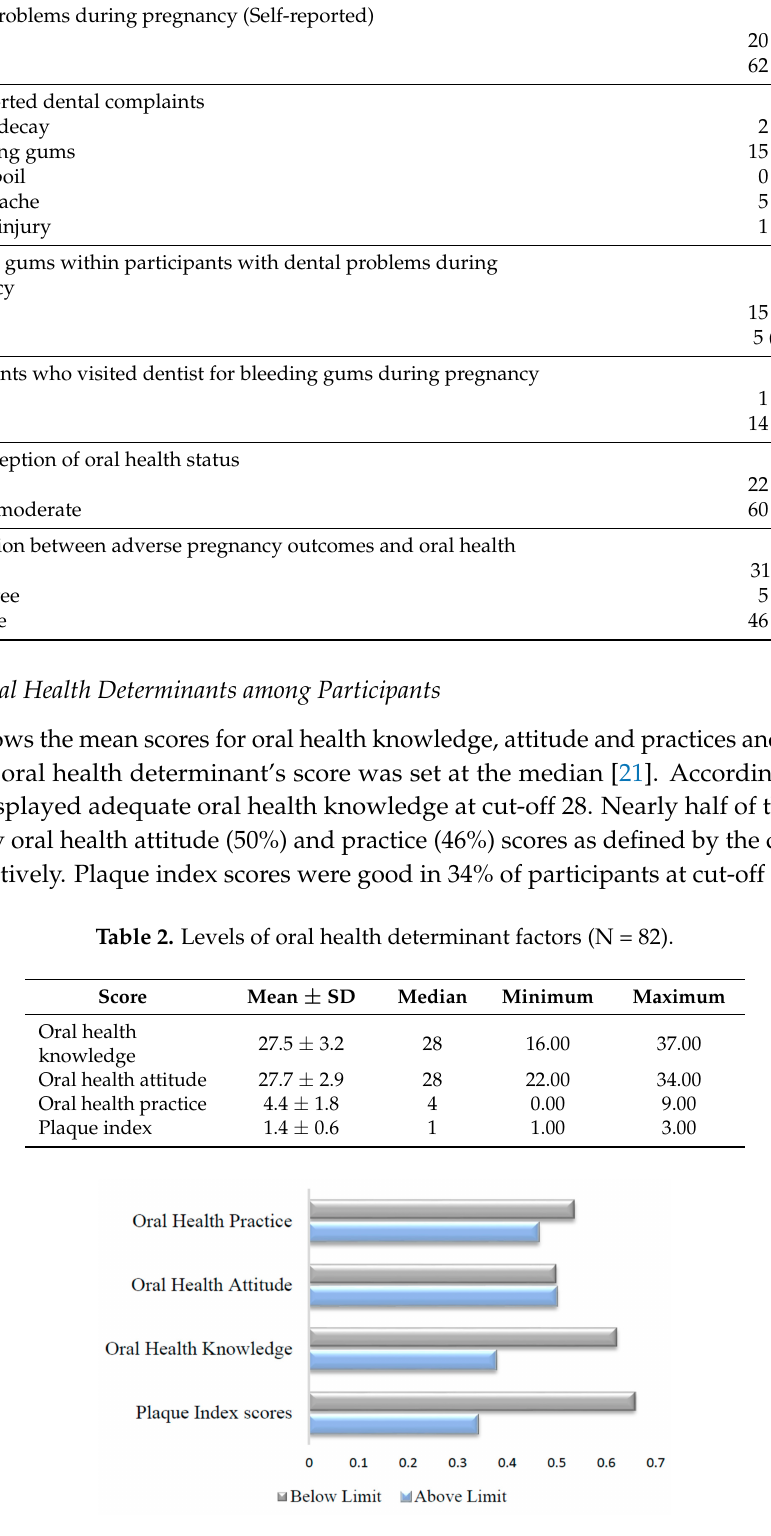
Figure 1. Distribution of scores of oral health determinant factors based on cut-off